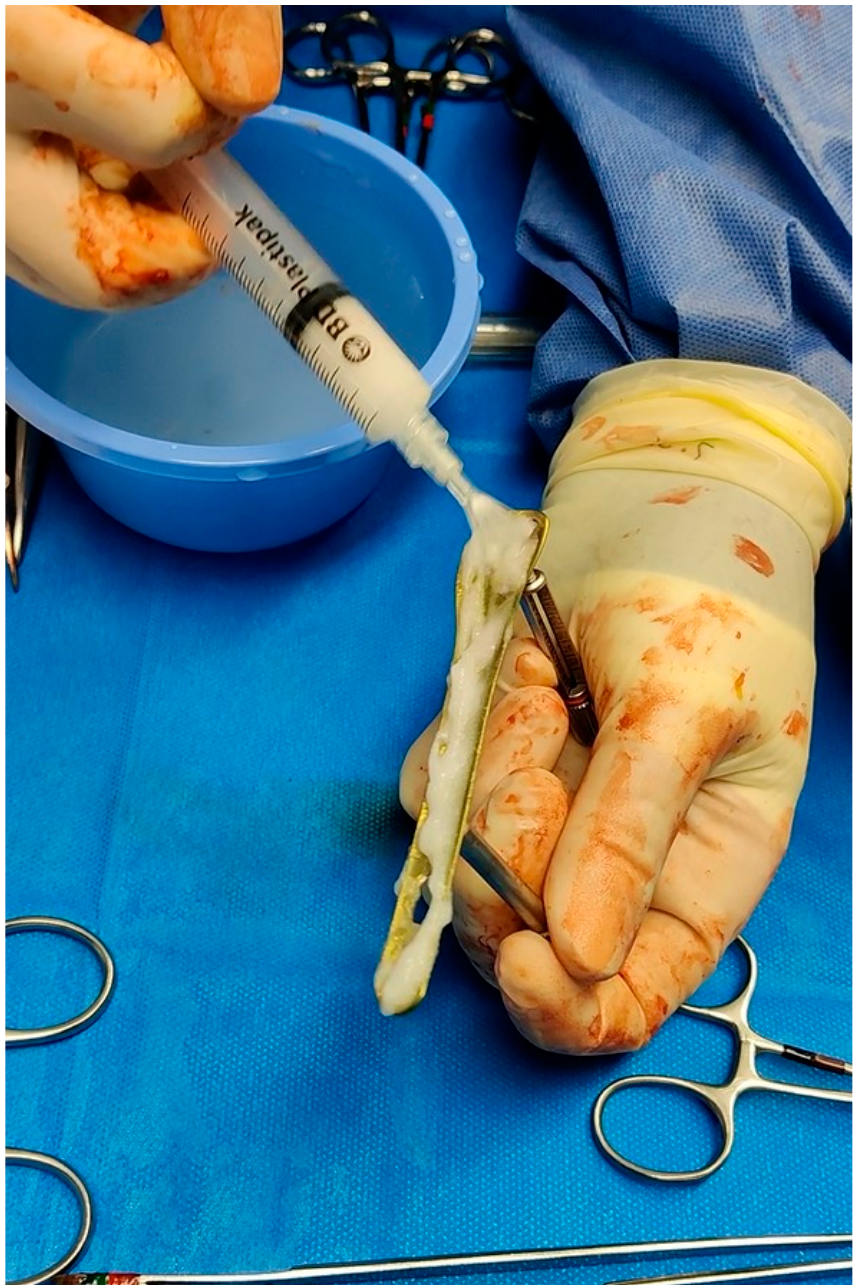
Figure 1. Intraoperative application of DAC gel over a distal fibula plate.